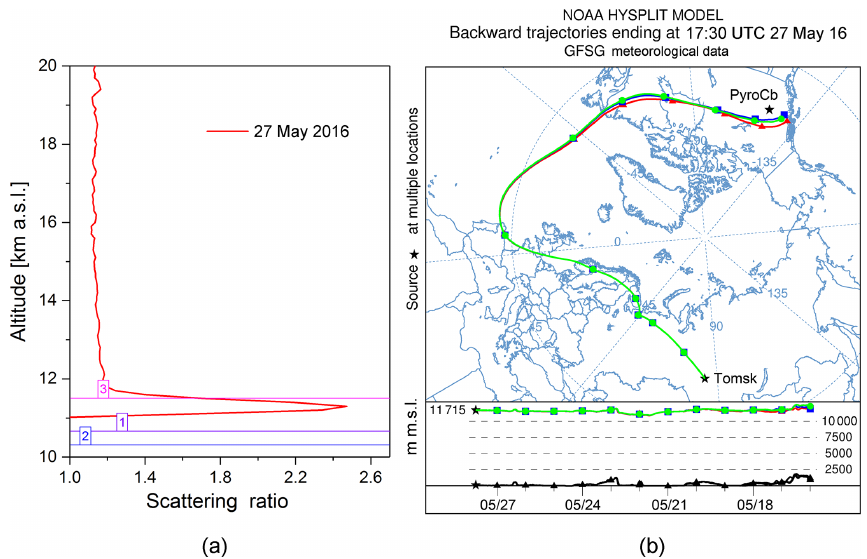
Figure 7. (a) Detection of a pyroCb plume from British Columbia in the TR–LS over Tomsk. The numbers 1–3 indicate the tropopause altitudes estimated in Kolpashevo, Emeljanovo, and Novosibirsk, respectively, at 17:30UTC on 27 May 2016. (b) Air mass backward ensemble trajectories started from altitude of ∼ 11 . 7km over Tomsk at the same